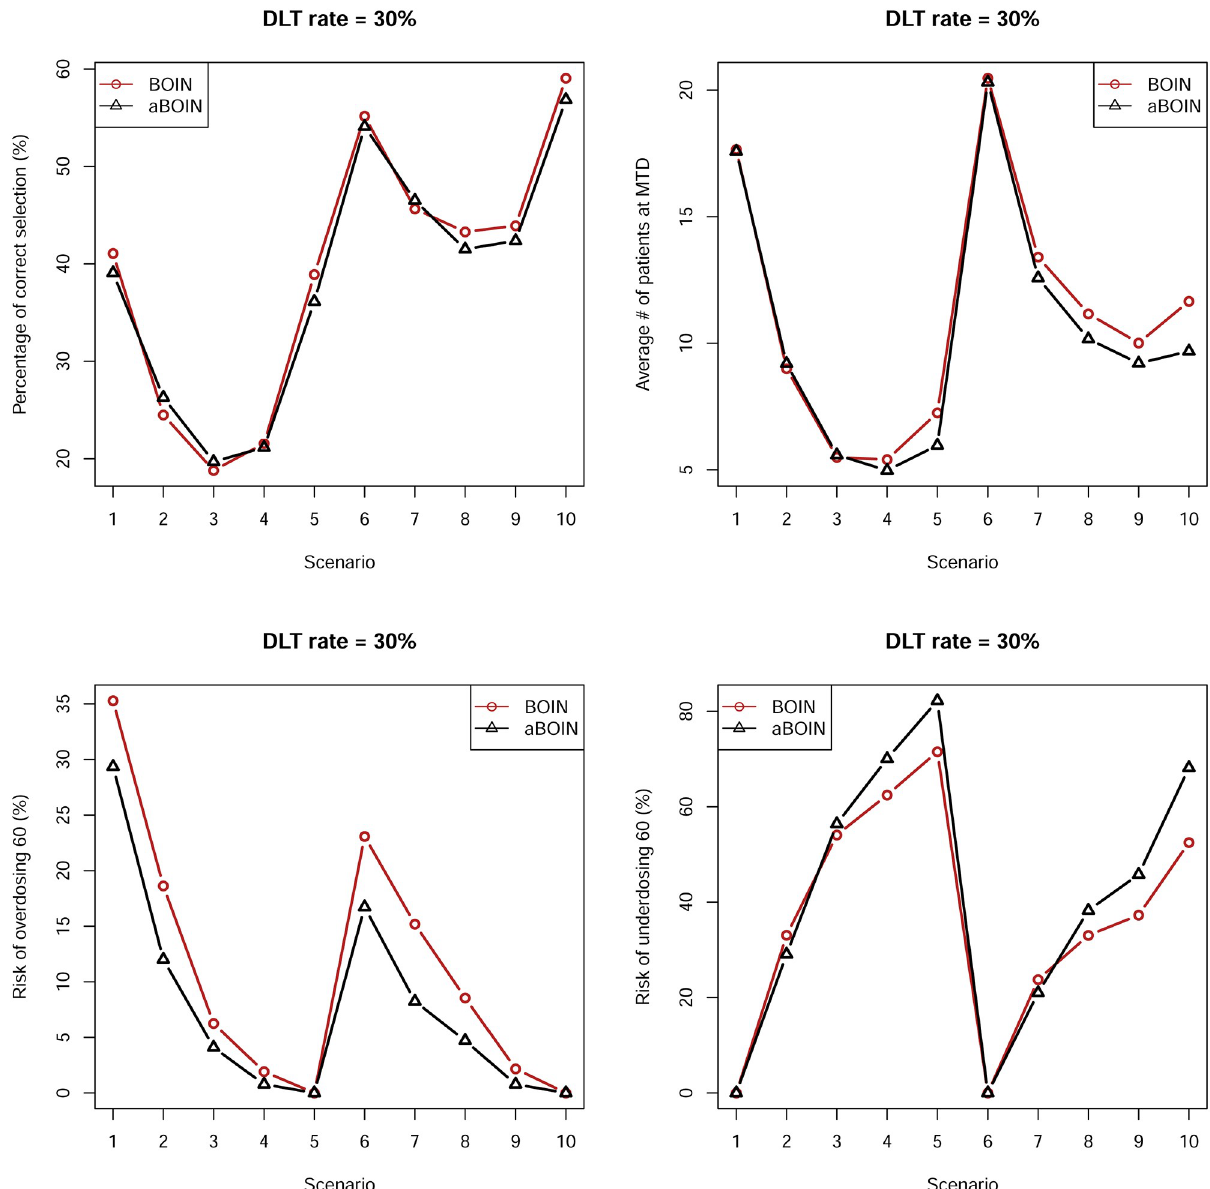
Fig 2. Operating characteristics of ten scenarios on the left panel (DLT 30%) of Table 2 by two competing methods BOIN and aBOIN.